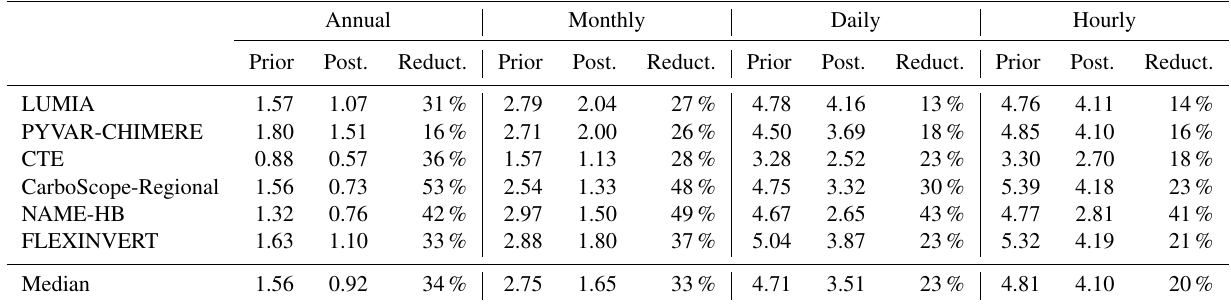
Table 3. Prior and posterior RMS difference (ppm) and percentage RMS difference reduction between modelled and observed concentra- tions, averaged hourly to annually. The average is first performed site by site, and then the site values are averaged together, with weights proportional to the length of each time series. Annual Monthly Daily Hourly Post. Reduct.